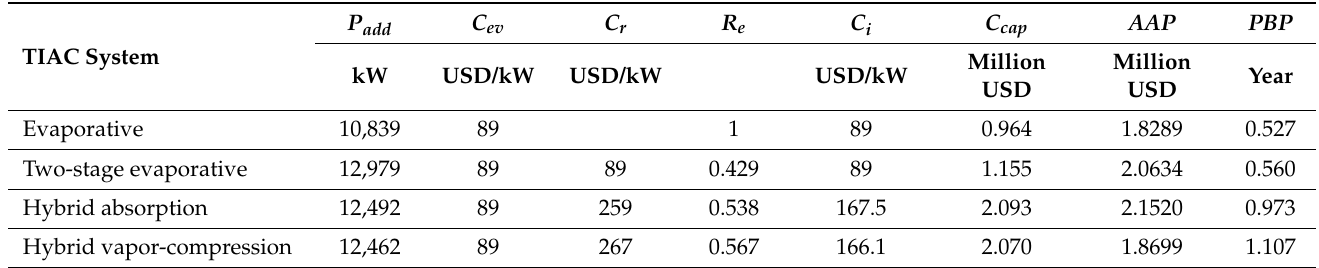
Table 3. Initial cost and payback